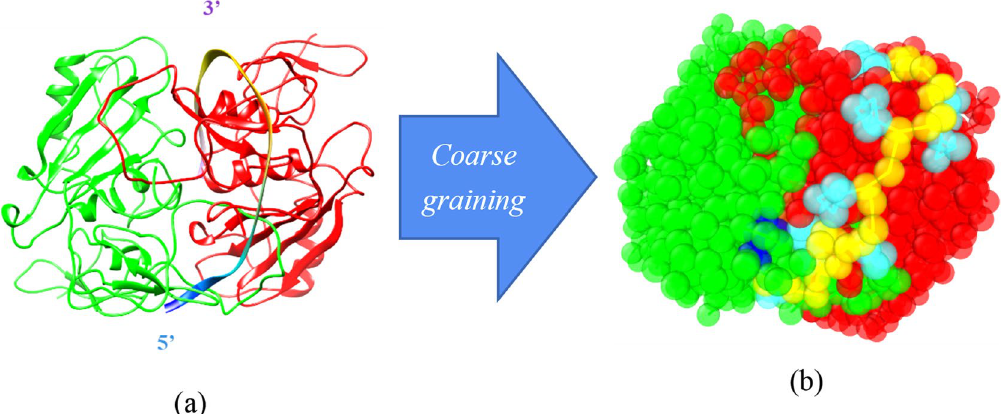
Figure 4. ( a ) The all atom model and ( b ) the corresponding MARTINI CG model for the most stable Apt EpA / EpCAM complex in vacuum. The Apt EpA backbone and nucleobase are shown in yellow and cyan, while the 5 ′ and 3 ′ beads are colored in dark blue and purple. The EpCAM dimer are colored in green and red,